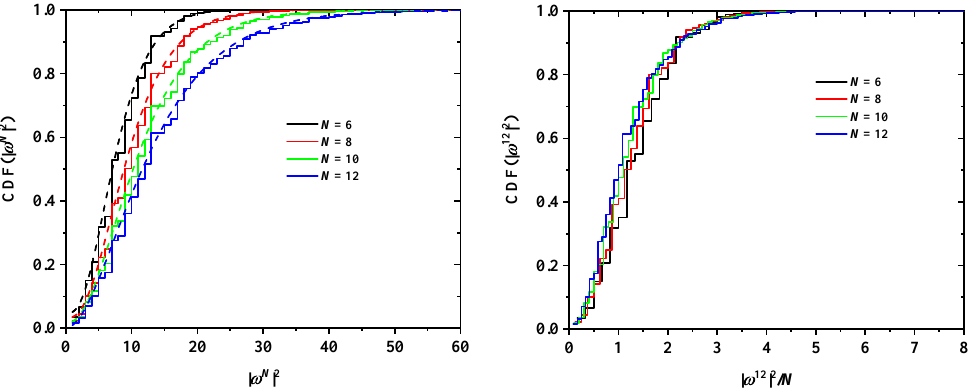
Figure 12. Cumulative probability distribution function for 2 × 2 tube and for SAW origin of type 1 (left panel) on restricted SC lattices. The right panel shows the same distributions, scaled by 1/ N , which for a step length of 1 is numerically equivalent to the characteristic ratio of the SAW [101]. Also shown in the left panel are best fits using the gamma function.